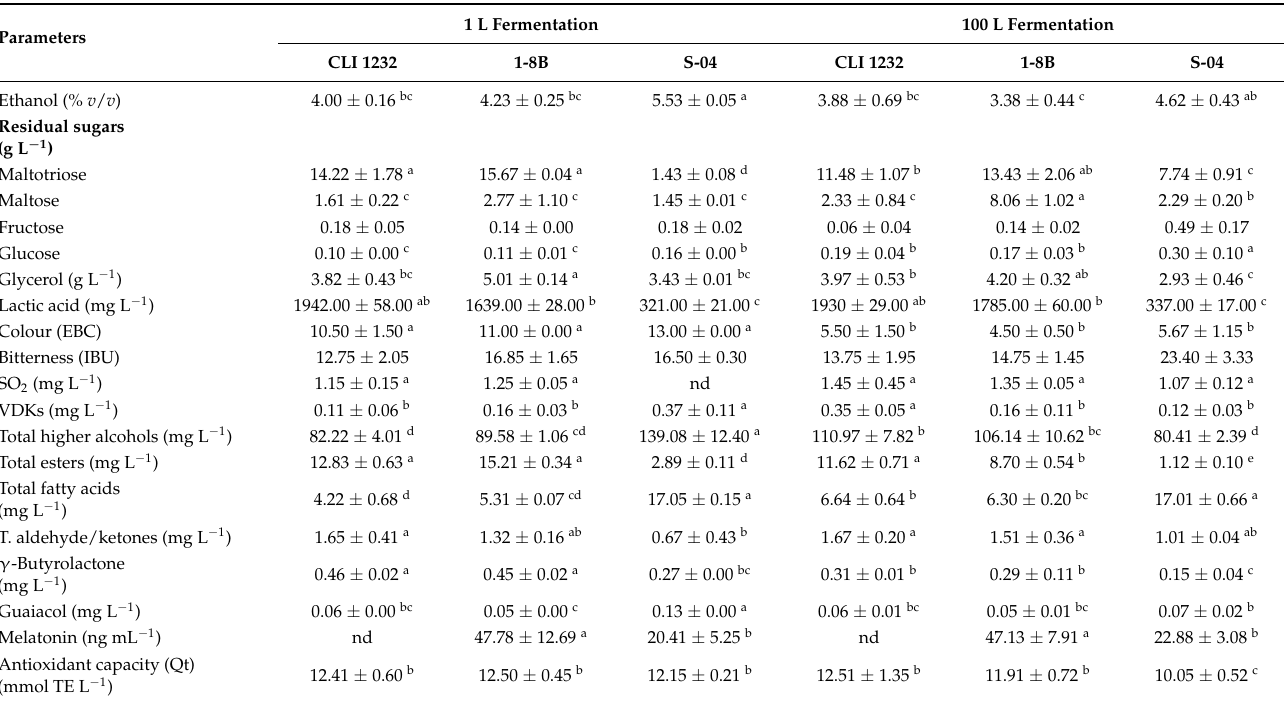
Table 6. Scale-up data comparison between 1 L and 100 L